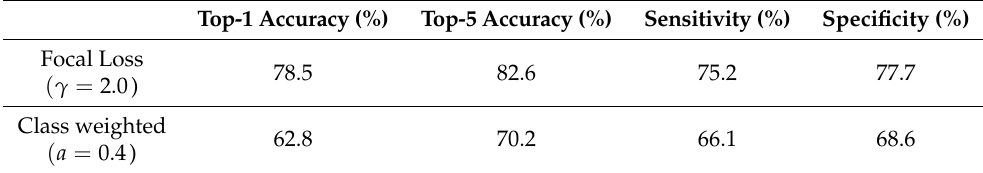
Table 5. Performance evaluation on real-life plants observation at UBD Botanical